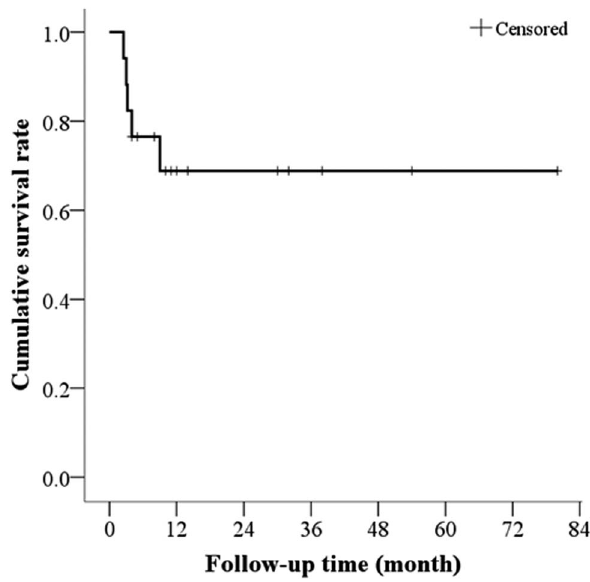
Figure 3. Cumulative survival rate (Kaplan-Meier).